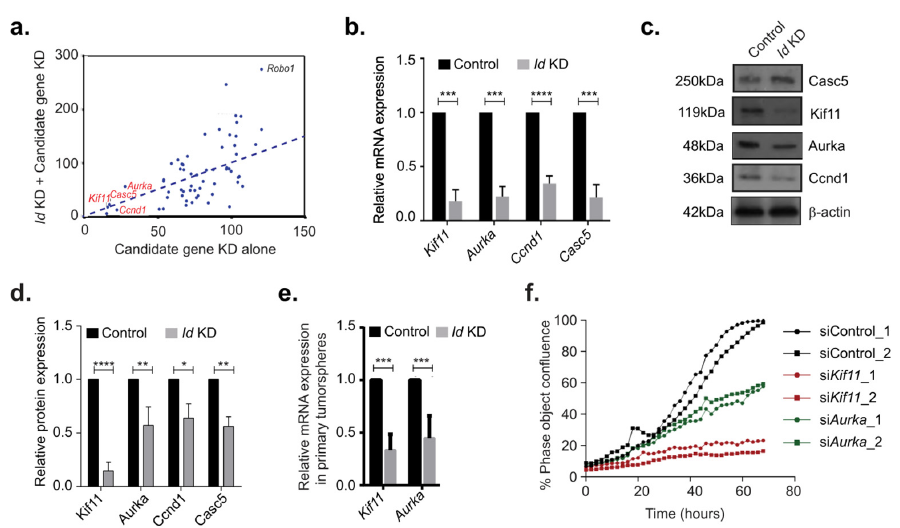
Figure 3. E ff ect of Id target gene knockdown on the proliferative phenotype. ( a ) The e ff ect of the candidate genes on proliferation of 4T1 cells were assessed by reverse transfection with a 40nM siGENOMESMART pool siRNA against each of the 61 genes. The target genes that showed the greatest e ff ect on the viability and thus the proliferative phenotype of the 4T1 cells with more than 50% were Kif11 , Aurka , Ccnd1 , and Casc5 . ( b ) The relative mRNA expression level of Kif11 , Aurka , Ccnd1 , and Casc5 in Id KD cells with respect to control cells were quantified with qRT-PCR. Data were normalized to β -actin and analyzed by the 2 − ∆∆ Ct method. ( c ) The expression of the Id target genes Kif11 , Aurka , Ccnd1 , and Casc5 at the protein level was decreased in Id KD cells when compared to the controls. ( d ) Quantification of relative protein expression of Kif11, Aurka, Ccnd1, and Casc5 in control and Id KD normalized with β -actin. ( e ) Relative mRNA expression level of Kif11 and Aurka in primary tumourspheres. ( f ) Percentage confluency in Kif11 KD and Aurka KD conditions, showing significant decrease in cell proliferation compared to the controls using two independent pMission siRNAs per gene. All experiments were performed in three biological replicates and data were expressed as mean ± standard deviation. Unpaired Student’s t -test and two-way ANOVA were used. * p < 0.05, ** p < 0.01, *** p < 0.001, **** p <